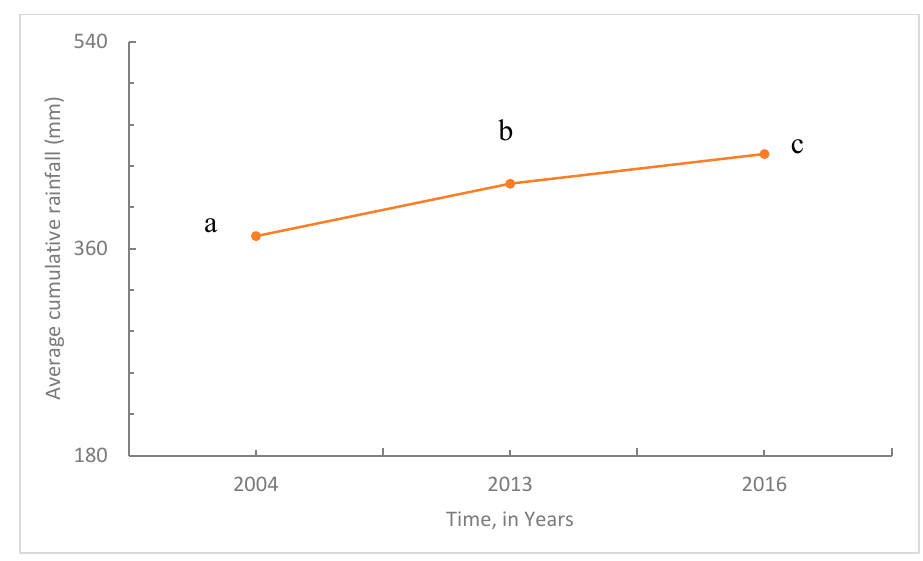
Figure 10. Average cumulative rainfall in three periods 1998–2011 ( a ), 2012–2014 ( b ) and 2015–2018 ( c ). The cumulative rainfall records considered here lie in the same day with 20 mm cumulative runoff depth records for each record year; that is the cumulative rainfall required for 20 mm run off generation.